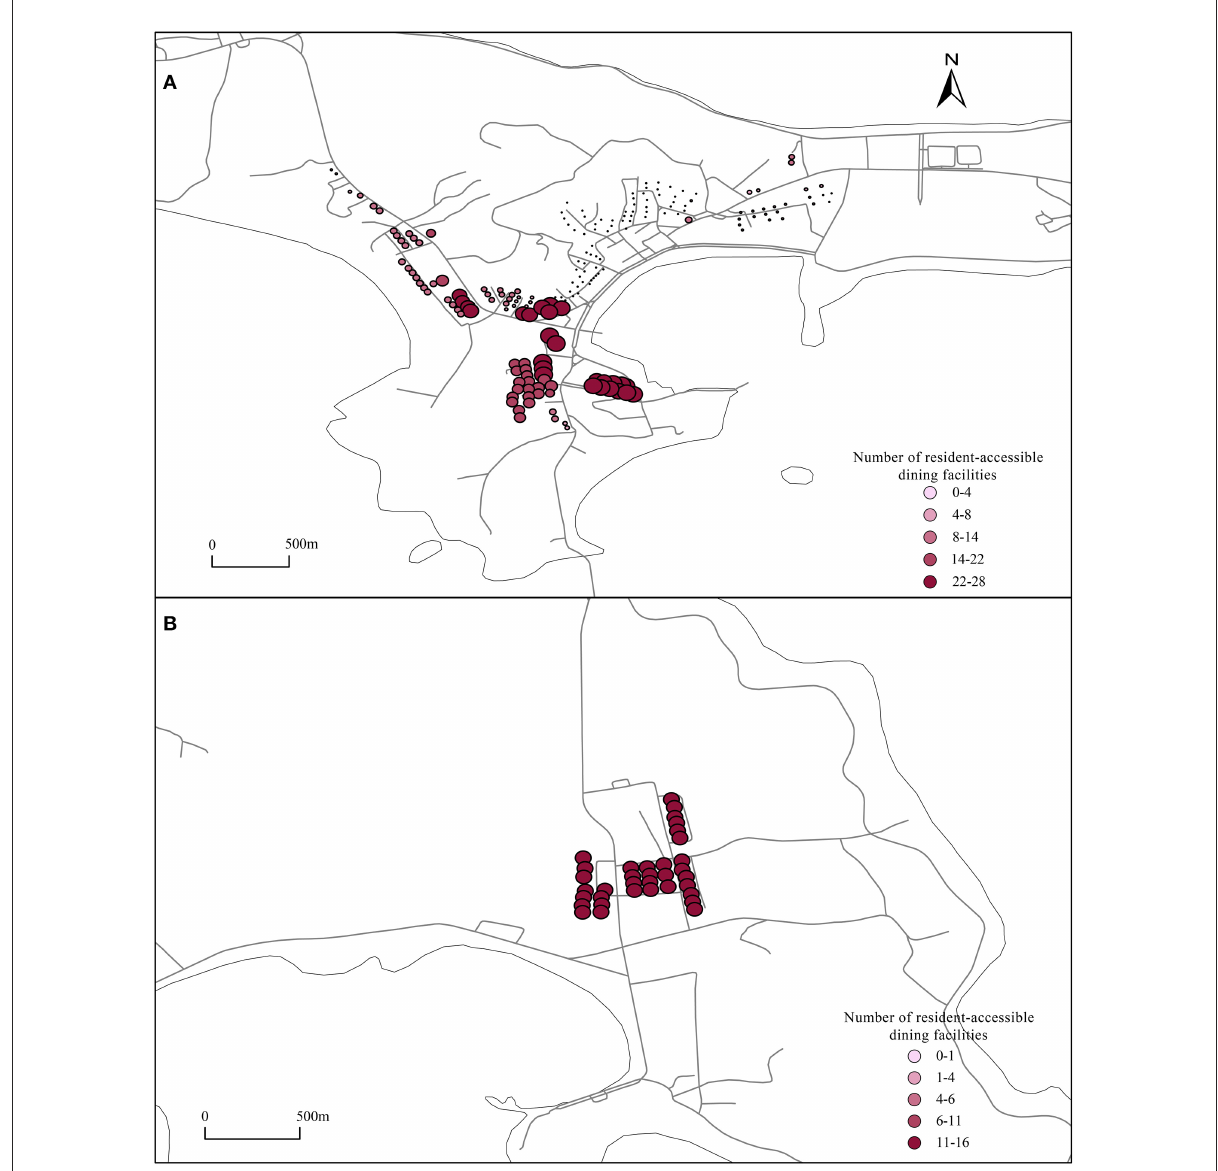
FIGURE7 Catering facilities accessible to residents. (A, B) Using the UNA analysis tool, set the residential buildings as the starting point, catering facilities as the ending point, import the road network, and calculate the number of catering facilities that can be reached from residential buildings within a range of 800